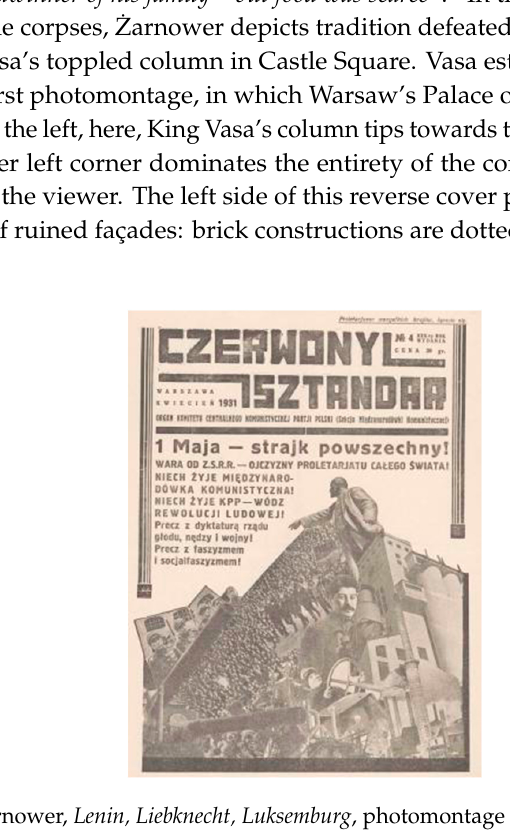
Figure 3. Teresa Ż arnower, Lenin, Liebknecht, Luksemburg , photomontage in Czerwony Sztandar ( Red Flag periodical), 1931, no 1, 30 cm × 22.5 cm. Arts 2020 , 9 , x FOR PEER REVIEW